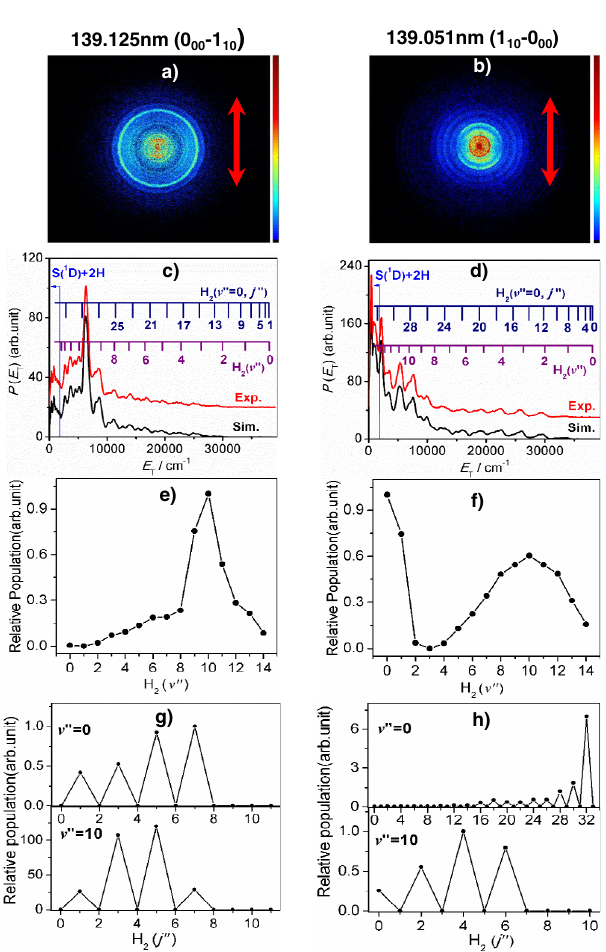
Fig. 4 The S( 1 D) + H 2 product translational energy distributions and the H 2 product quantum state population distributions. Time-sliced velocity map images of the S( 1 D 2 ) photofragments from photolysis of H 2 S at λ = a 139.125 and b 139.051 nm with ε phot aligned vertically in the plane of the image (as illustrated by the double-headed red arrow). The P ( E T ) spectra derived from these images are shown in c and d , in red, along with the best- fi t simulations of the spectra at E 1 D) + H T values down to the S( 2 dissociation threshold, in black and offset vertically for clarity. The superposed combs in c and d indicate the E T values associated with formation of the various H 2 ( v ” , J ′′ = 0) and, respectively, the ortho - and para-J ′′ states of H v ′′ = 0). The energetic limit of the S( 1 D) + 2H channel 2 ( is marked by the vertical blue line. e and f show the H 2 ( v ′′ ) state population distributions returned by the respective best- fi t simulations, while g and h show the J ′′ state population distributions for H 2 products in representative low ( v ′′ = 0) and high ( v ′′ = 10) vibrational states formed at each wavelength. The raw data are provided as a Source Data fi